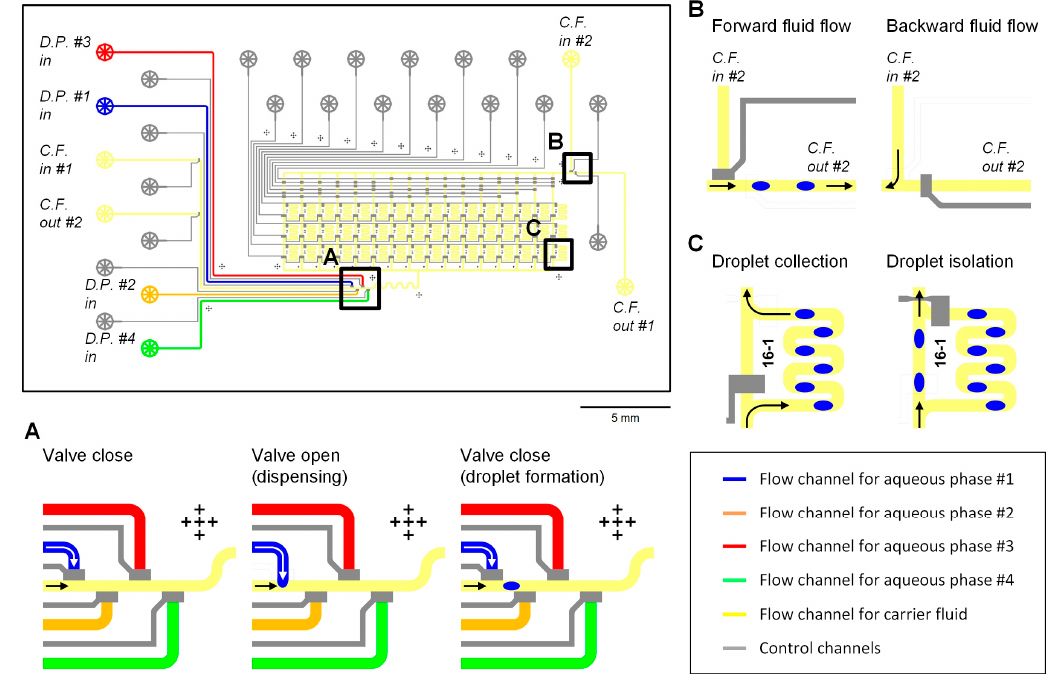
Figure 1. Design and operation of the microfluidic droplet-storage array. A computer-aided design shows the integration of 4 droplet generators and 48 droplet-storage units; ( A ) process flow of the droplet generation by using a microfluidic valve; ( B ) fluid flow direction control by switching a carrier fluid flow channel connection between the two sets of an inlet and an outlet; ( C ) valve operation to collect and isolate droplets in a droplet-storage unit.